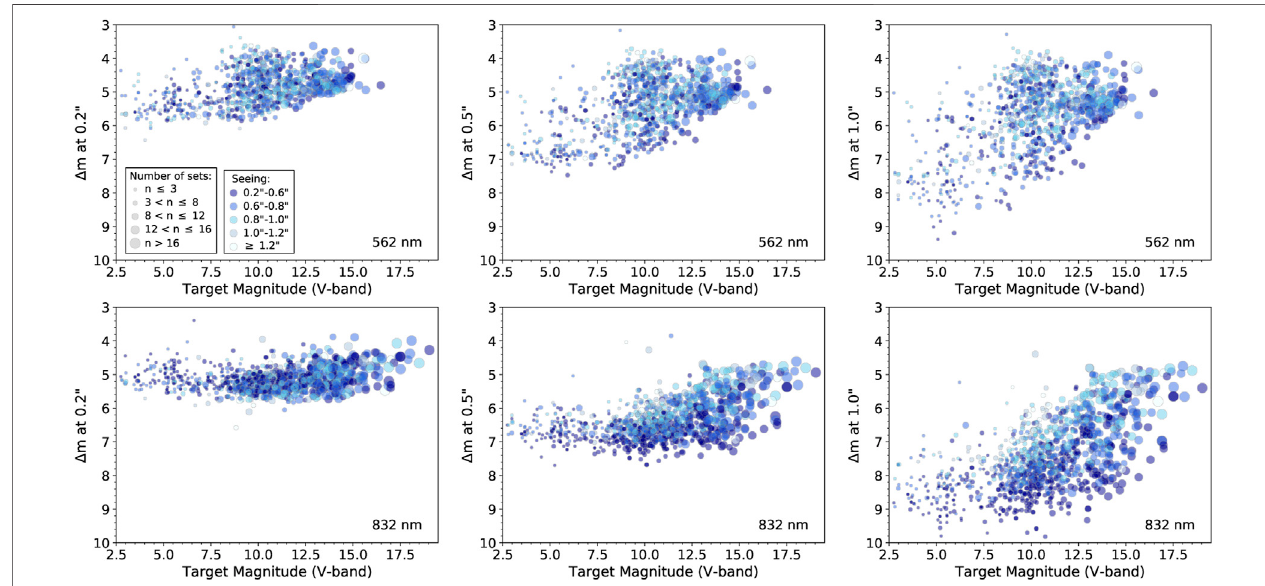
FIGURE8| Combinedresultsfromthecontrastcurvesofall ‘ Alopekeobservationsfromthe2019Atothe2021Bsemestershowing Δ mvaluesatspatialdistances of 0.2, 0.5, and 1.0 ″ vs . the V-band magnitude ofthe target stars. Thesymbolsize scaleswiththe number of sets (where 1set consists of1,000 ×60 msecexposures), and the color scales with seeing (darker blue indicates better seeing